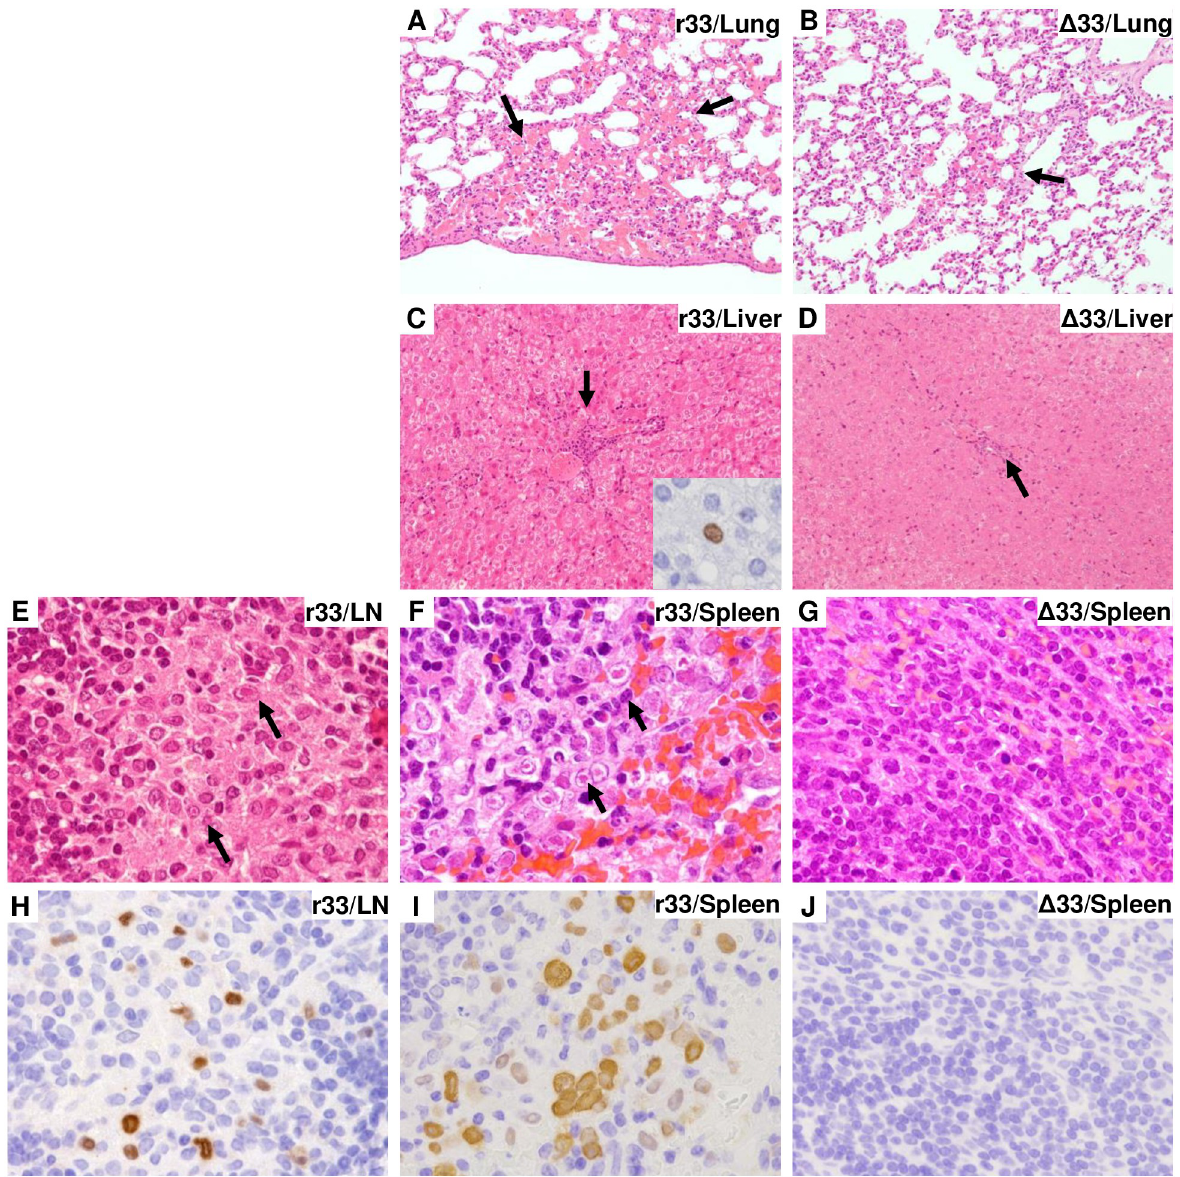
Fig 7. Pathological findings in r33- and Δ 33-infected dams at 6 days p.i. Formalin-fixed specimens prepared from the dams described in the legend for Fig 5 were histologically analyzed. (A, B) Severe inflammatory cell infiltration with hemorrhage was observed more frequently in the lungs of the r33-infected dams (A) than in those of Δ 33-infected dams (B). (C, D) Severe inflammation was observed in the portal area in the liver of r33 virus-infected guinea pigs, and GPCMV-antigen-positive cells were found by immunohistochemical analysis (inset) (C). Minor inflammatory infiltration (arrow) was found in the liver of Δ 33-infected guinea pigs (D). (E, H) HE staining shows intranuclear inclusion bodies in the lymph nodes of one of the r33-infected guinea pigs (E, arrows). Immunohistochemical analysis of cells demonstrated GPCMV-positive cells in the lymph nodes (H). (F, G, I, J) Intranuclear inclusion bodies (F, arrows) and many GPCMV-positive cells were found in the spleens of r33-infected guinea pigs (I) by HE staining and by immunohistochemical analysis, respectively. In contrast, no abnormalities or viral antigens were detected in the spleens of Δ 33-infected guinea pigs (G,